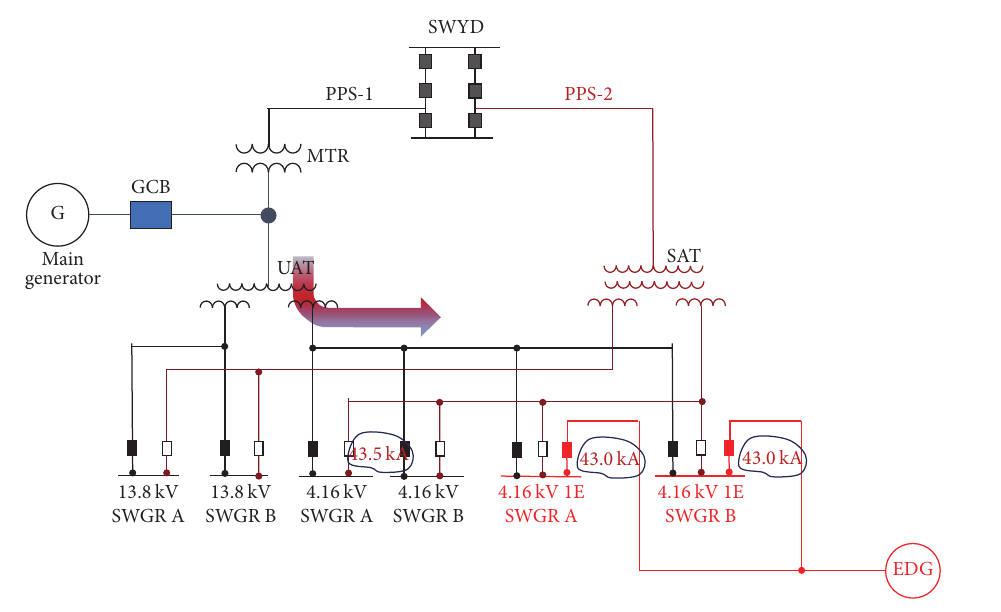
Figure 3: Short circuit current during the normal operation with EDG